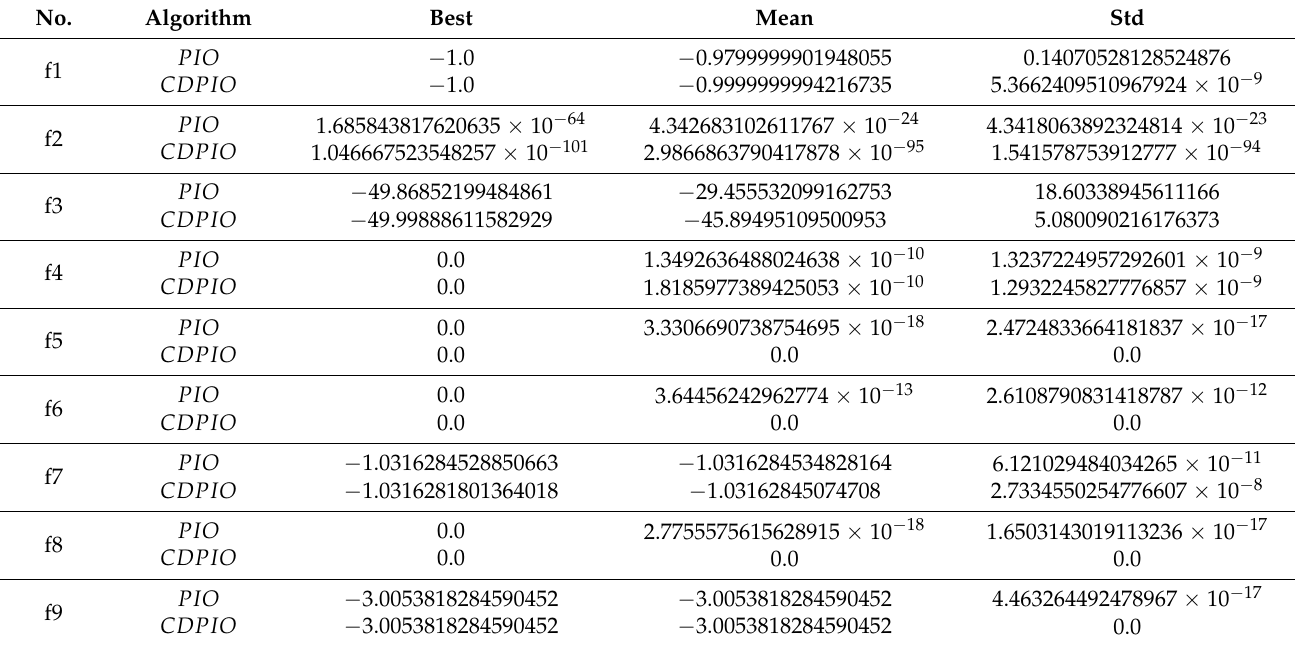
Table 3. Optimization results comparison of benchmark